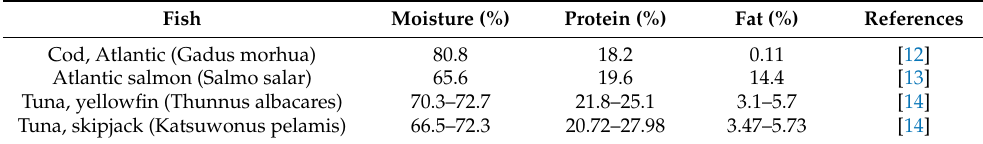
Table 1. Moisture, protein, and fat content of selected fish